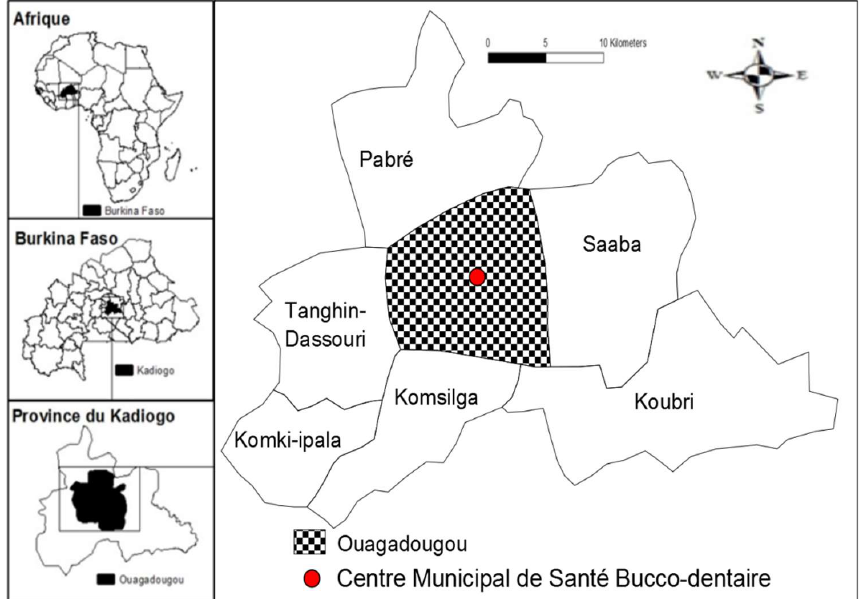
Figure 1. Map of Kadiogo Province with the study sites